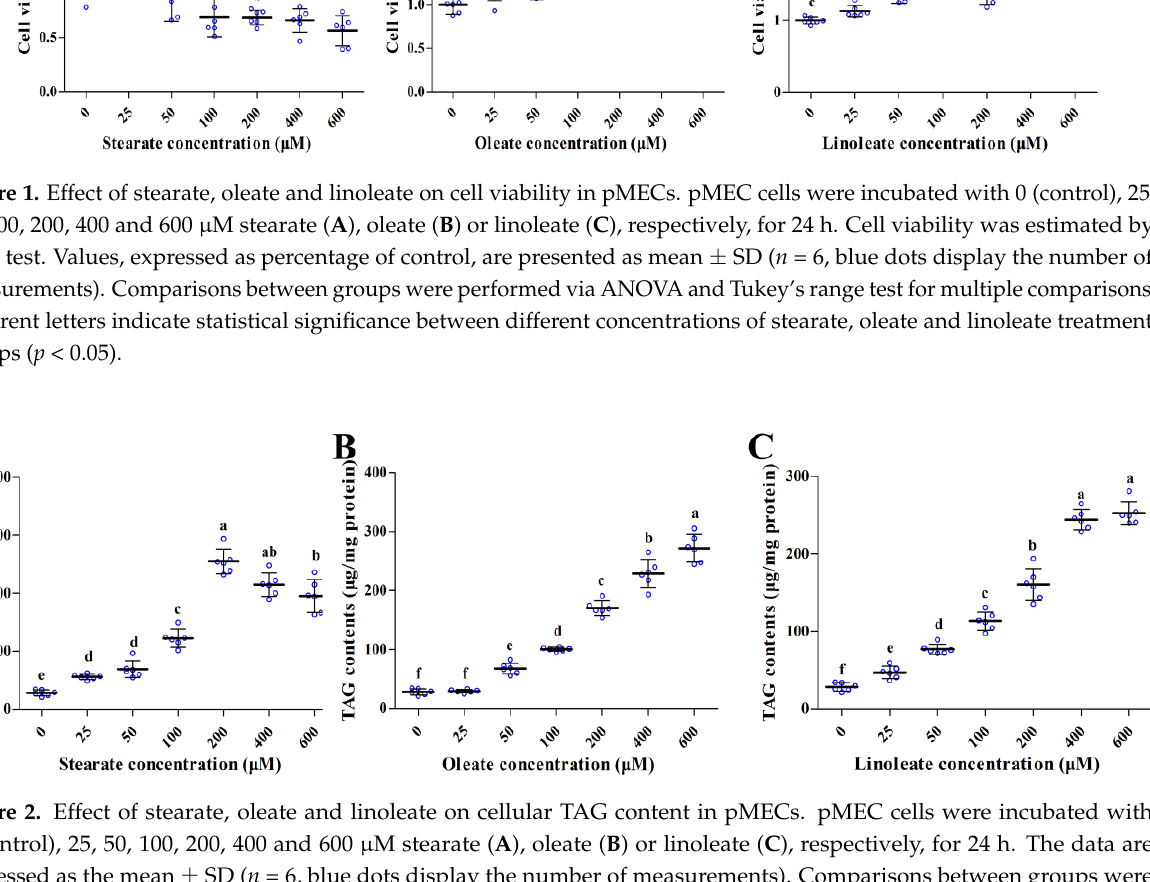
Figure 1. Effect of stearate, oleate and linoleate on cell viability in pMECs. pMEC cells were incubated with 0 (control), 25, 50, 100, 200, 400 and 600 μM stearate ( A ), oleate ( B ) or linoleate ( C ), respectively, for 24 h. Cell viability was estimated by MTT test. Values, expressed as percentage of control, are presented as mean ± SD ( n = 6, blue dots display the number of measurements). Comparisons between groups were performed via ANOVA and Tukey’s range test for multiple comparisons. Different letters indicate statistical significance between different concentrations of stearate, oleate and li- noleate treatment groups ( p < 0.05).